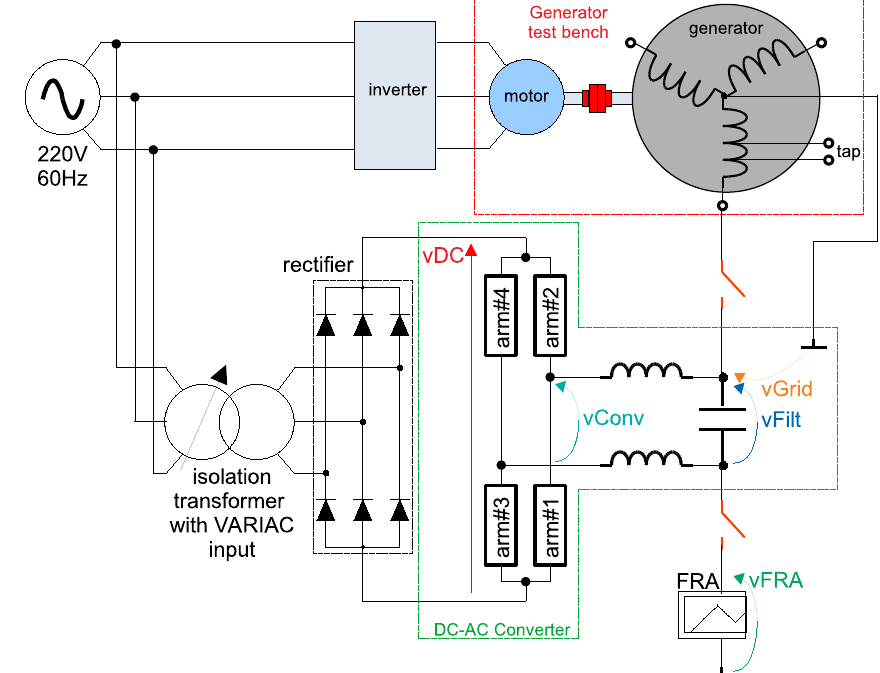
Figure 8. Schematics of the test